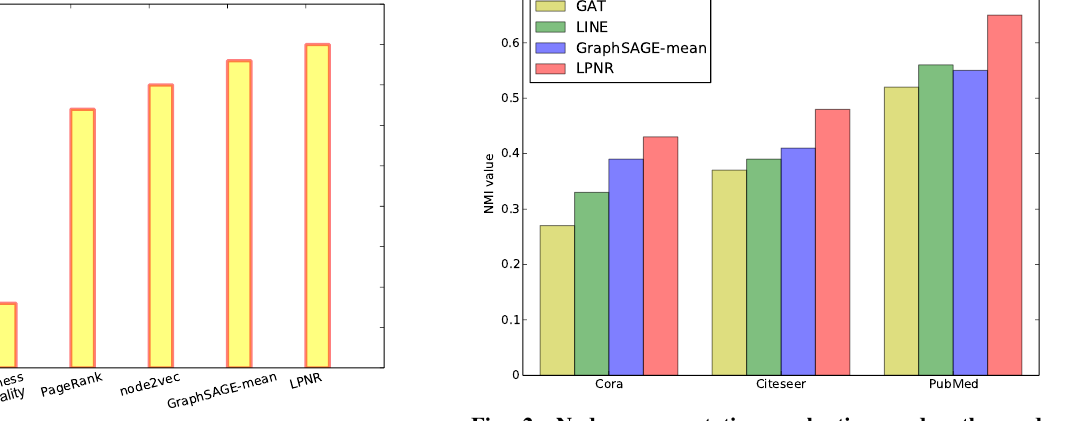
Fig. 1 Comparison of ranking performance under different ranking methods.